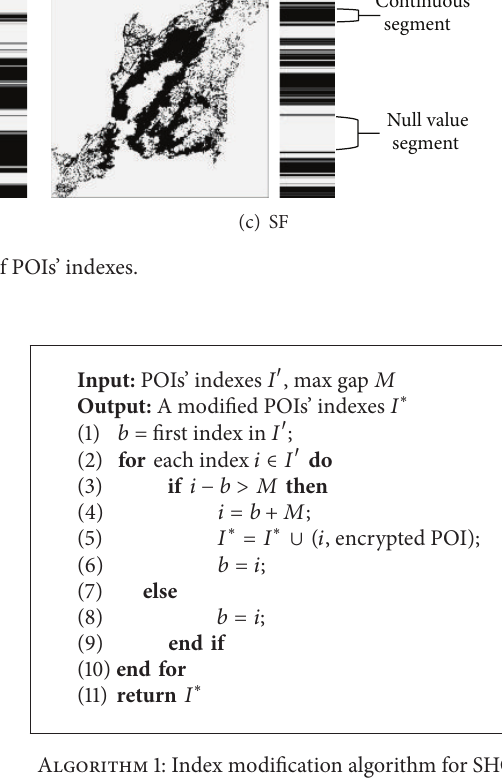
Algorithm 1: Index modification algorithm for